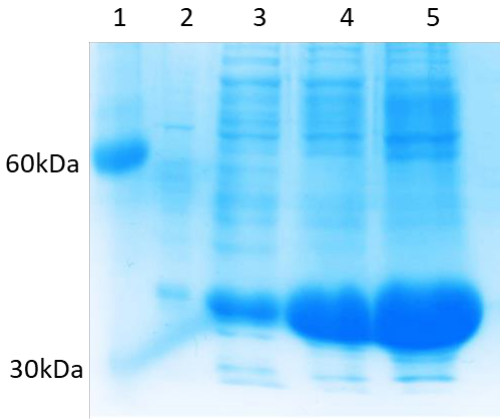
Figure 4. Modified Concanavalin (CNV44) Recovery. 1 = Molecular marker, 2 = Soluble fraction, 3 = Insoluble fraction urea 2M, 4–5 = Insoluble fraction urea 6 M.